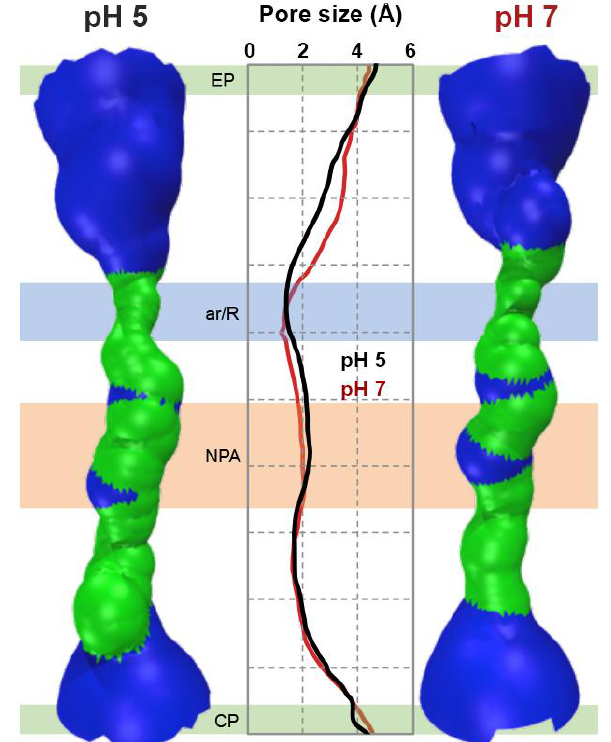
Figure 3. Pore size of hAQP7 monomer A at pH 5.0 and pH 7.0. Surface of a representative snapshot of monomer A (based on van der Waals radii): Red = smaller than single H 2 O, green = single H 2 O, blue = larger than single H 2 O. Pore size represented as an average of all monomers in five simulations at each pH value (pH 5.0 in black and pH 7.0 in red traces). EP–extracellular pocket, ar/R– aromatic/arginine selectivity filter, NPA–NPA motif, CP–cytoplasmic pocket. Figure generated by